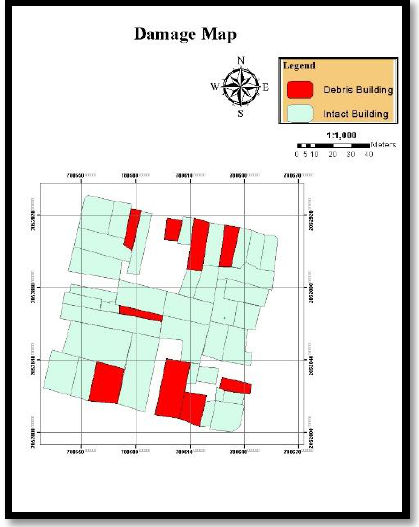
Fig.8 Resulted damage map using proposed